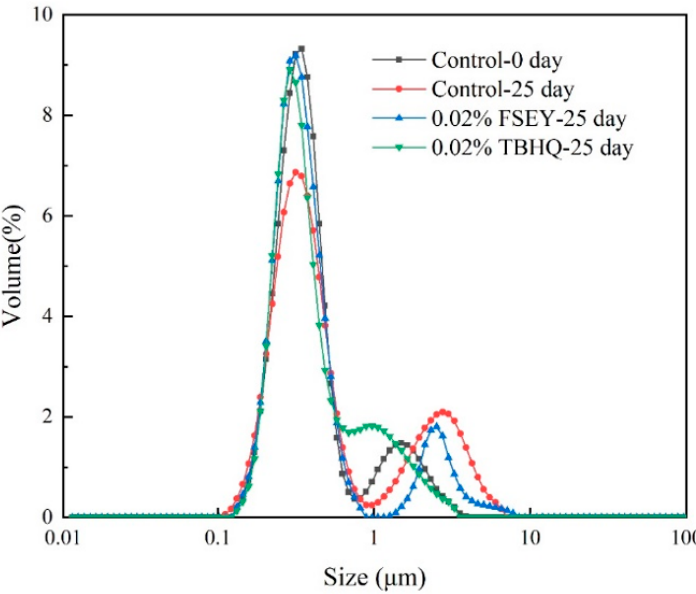
Figure 5. Particle size distribution. Table 1. ζ‐ potential values (mV) and volume mean diameter.